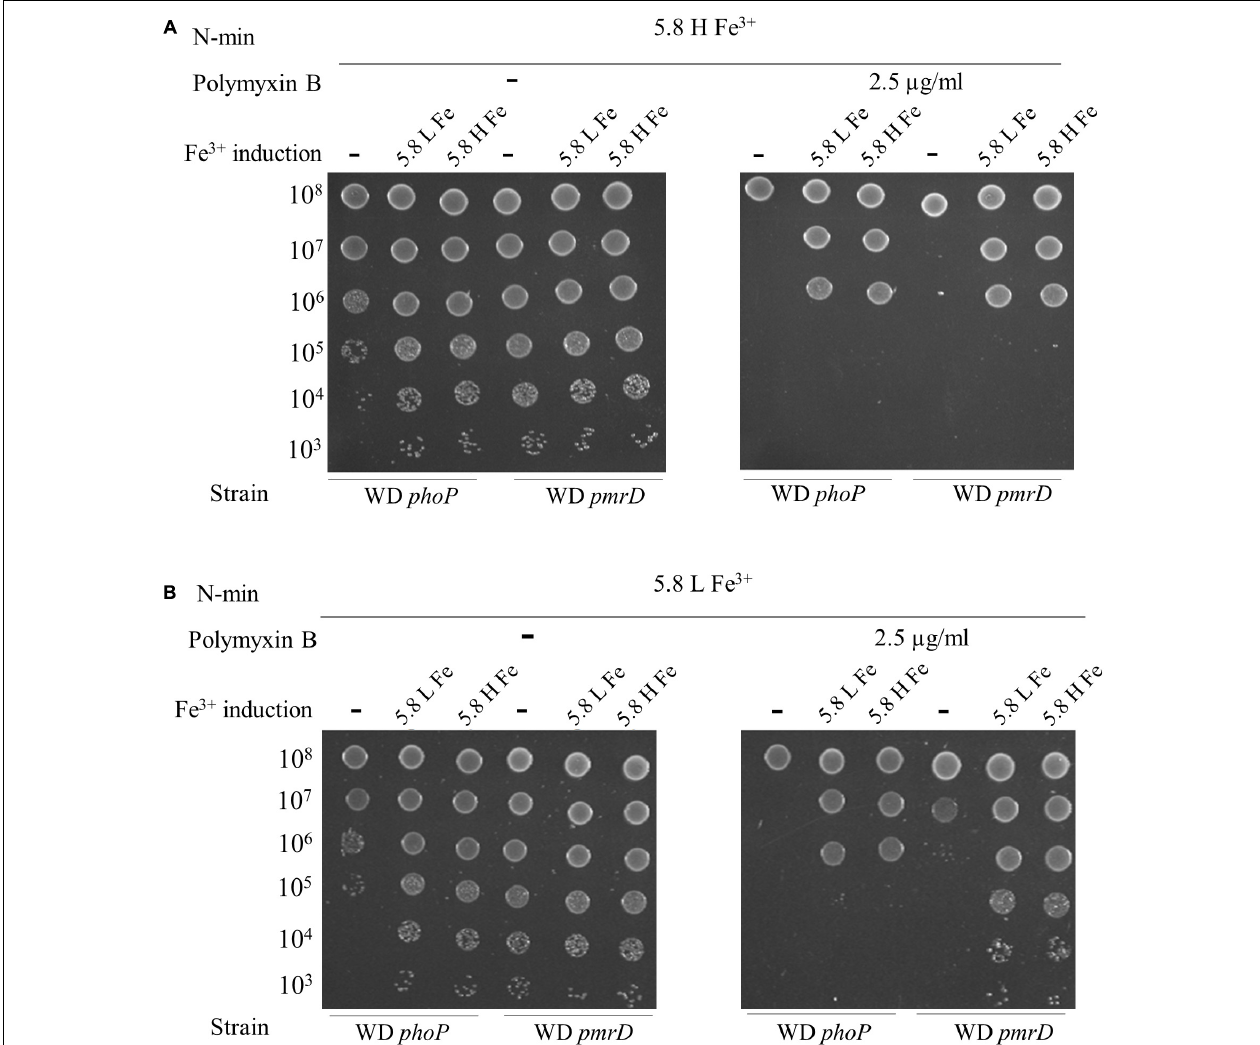
FIGURE 4 | PhoP and PmrD contribute differentially to polymyxin B resistance. W3110 phoP and pmrD mutants were grown overnight in N-min at pH 7.5 and low Mg 2 + . Cells were diluted (1:50) and incubated for 4 h at 37 ◦ C in the same medium (–) or in a Fe 3 + induction medium (+) that is N-min at pH 5.8, low Mg 2 + and high Fe 3 + (5.8 L Fe 3 + ) or N-min at pH 5.8, high Mg 2 + and high Fe 3 + (5.8 H Fe 3 + ). 5- µ l spots of appropriate dilutions were then plotted on plates supplemented or not with 2.5 µ g/ml of polymyxin B, as follows: (A) N-min at pH 5.8, high Mg 2 + and high Fe 3 + (5.8 H Fe 3 + ). (B) N-min at pH 5.8, low Mg 2 + and high Fe 3 + (5.8 L Fe 3 + ). The data are representative of at least three independent